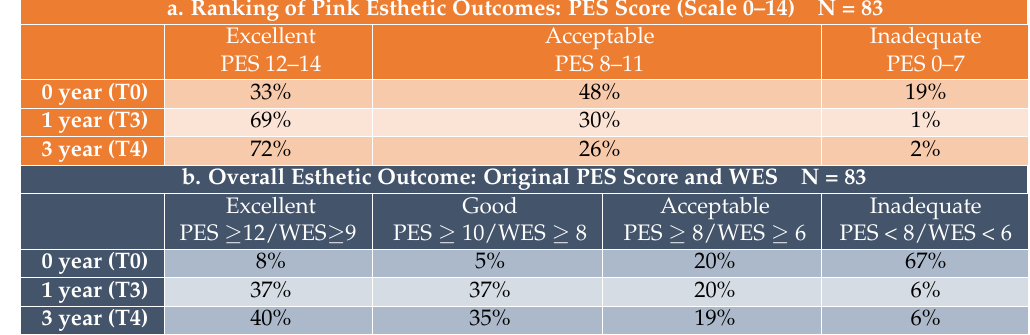
Table 3. (a) Ranking of “pink esthetic outcomes” using the original PES. (b) “Overall esthetic scores” using a combination of original PES and WES.